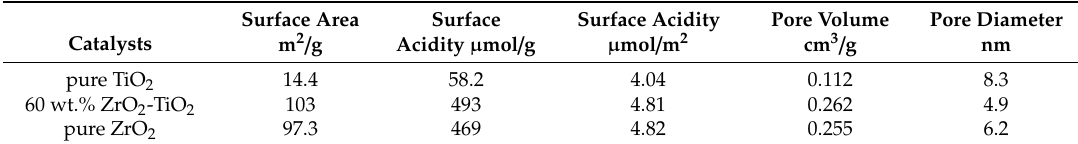
Table 2. Selected surface properties of studied catalysts.